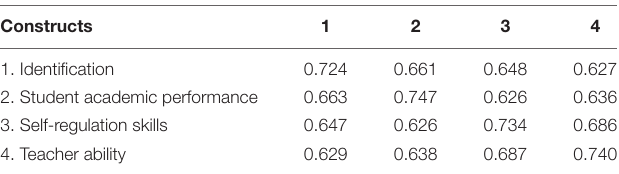
TABLE 6 | Hypotheses testing mediation